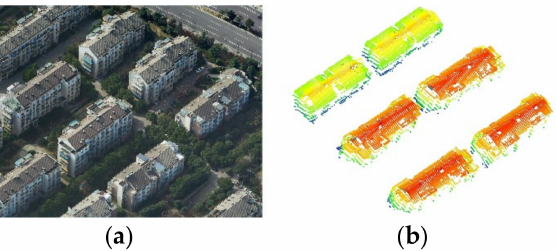
Figure 2. High-rise building: ( a ) aerial image corresponding to high-rise buildings; ( b ) high-rise building point